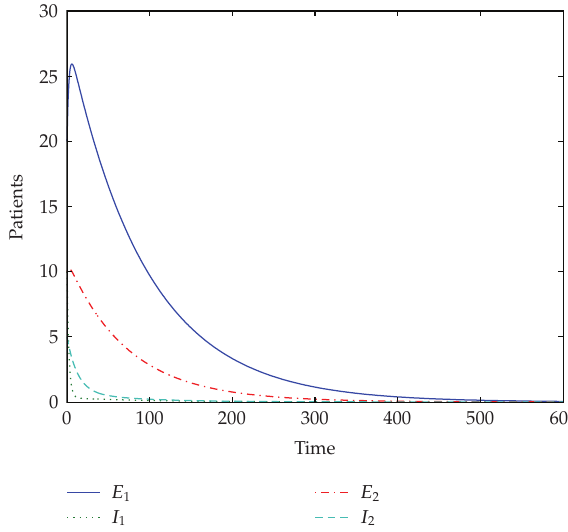
Figure 8: Trajectories of system (cid:2) 2.2 (cid:3) when β 1 (cid:2) N (cid:3) (cid:8) β 1 /N , β 2 (cid:2) N (cid:3) (cid:8) β 2 /N , β 1 (cid:8) β 2 (cid:8) 0 . 001, d 1 (cid:8) 0 . 02, d 2 (cid:8) 0 . 07, so that R 1 < 1, R 2 < 1. It shows that the disease-free equilibrium P 0 is stable.